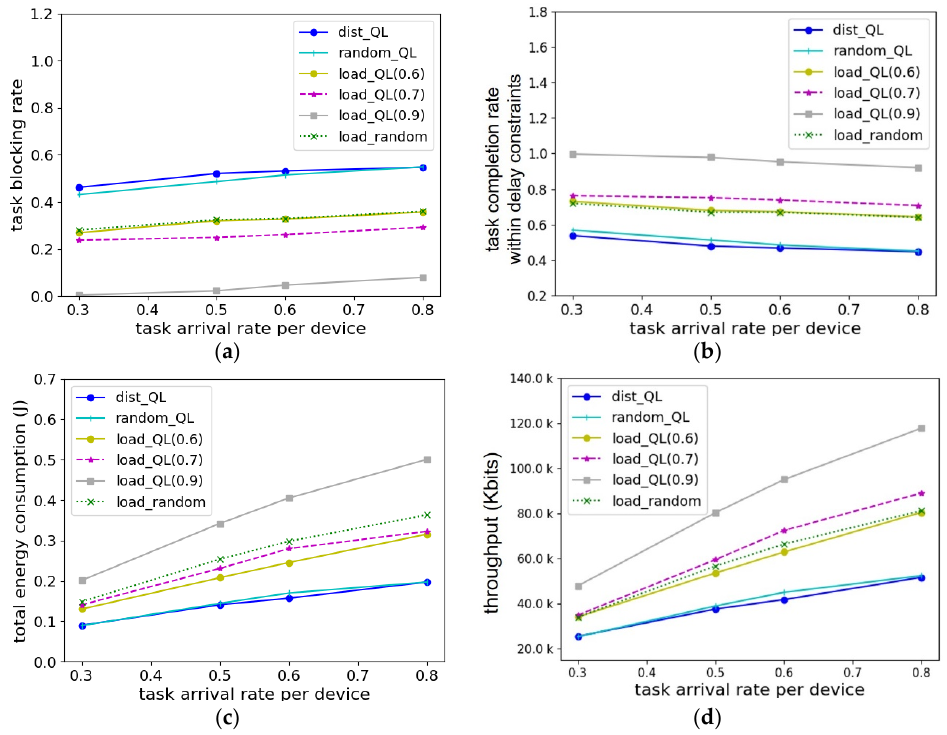
Figure 3. Performance comparison according to task arrival rate per device and the method of selecting the MECS and D2D device and determining offloading strategy decision: ( a ) task blocking rate; ( b ) task completion rate within delay constraints; ( c ) total energy consumption ( J ); ( d ) throughput.